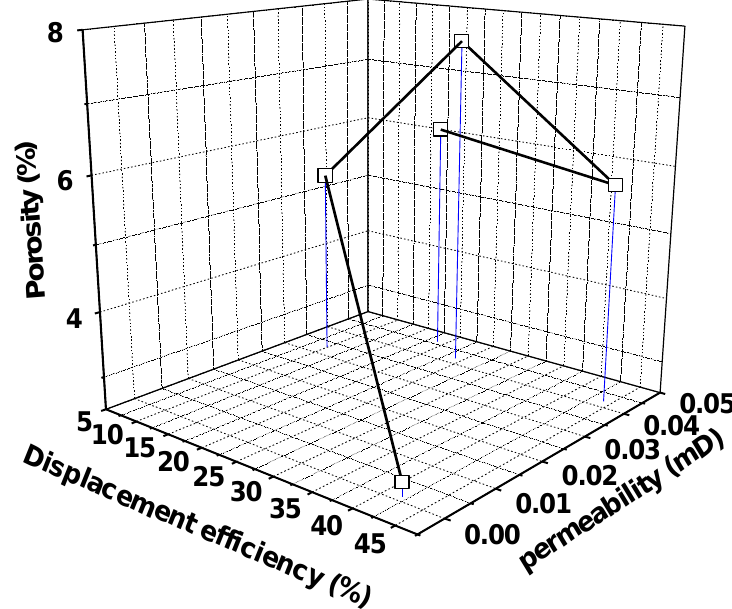
Figure 17. Displacement efficiency versus permeability and porosity.